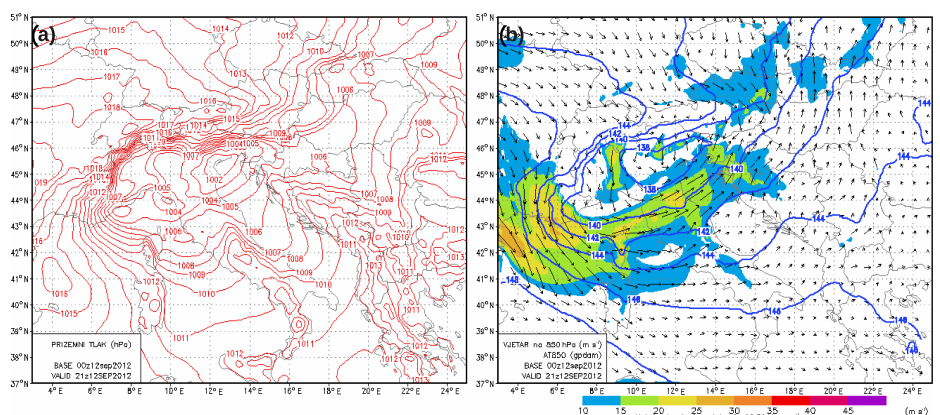
Figure 11. Mean sea level pressure (a) and 850hPa geopotential height (blue isolines), wind speed (background shading) and direction (vectors) (b) according to the ALADIN model operational forecast on 21:00UTC 12 September 2012 (starting from the 00:00UTC analysis of the same day).